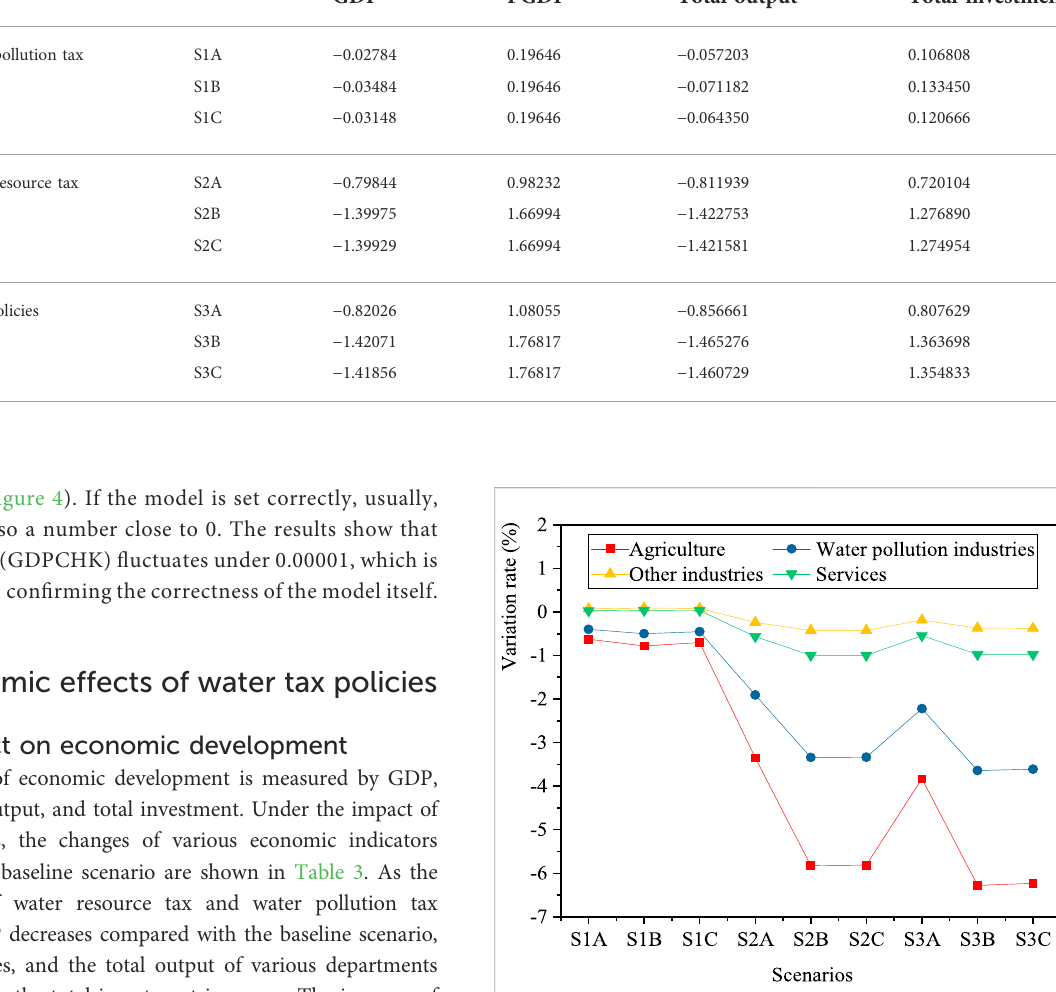
FIGURE 5 Output variation of different industries under different scenarios